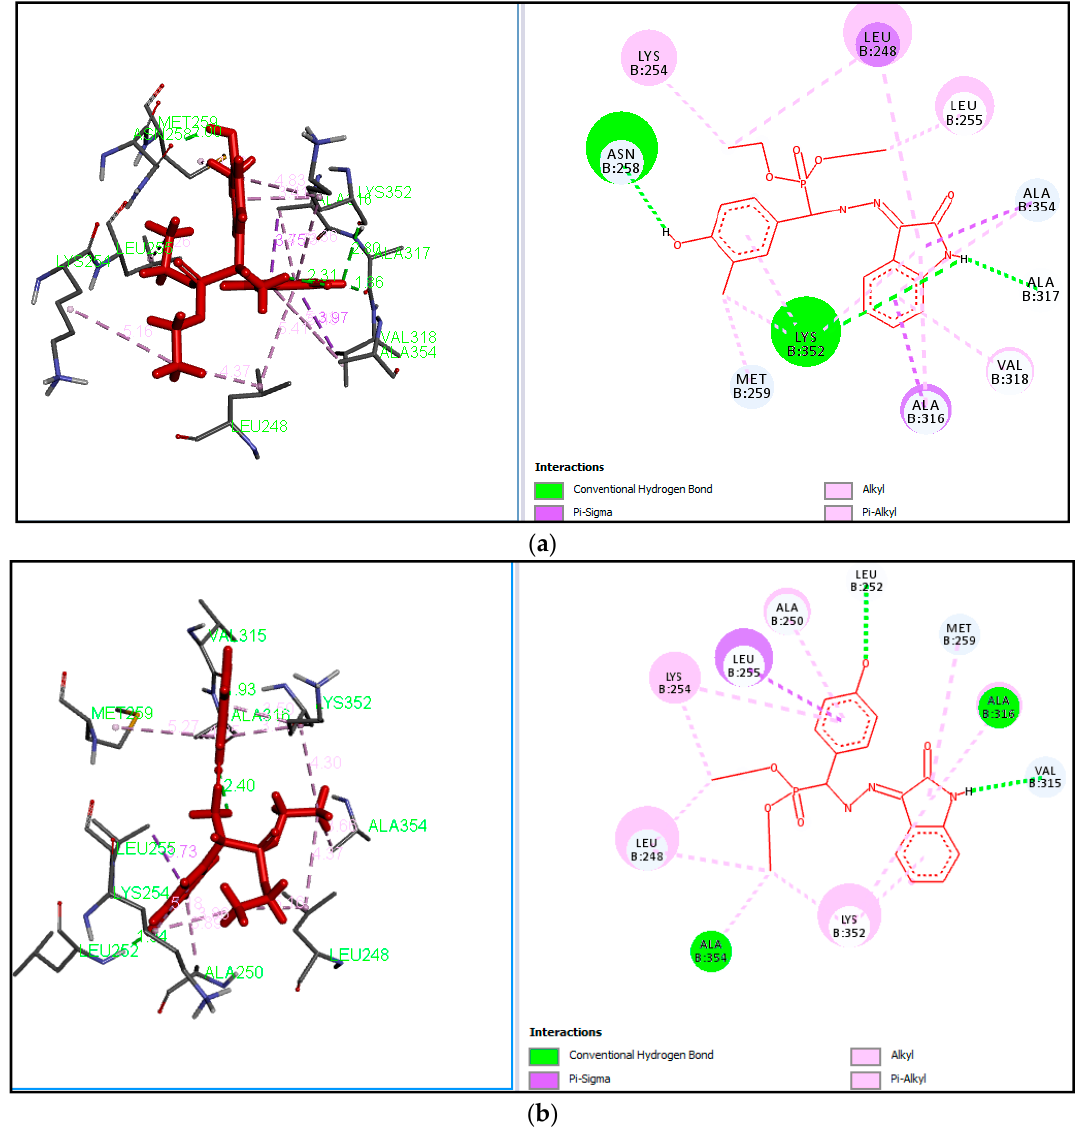
Figure 4. ( a ) Binding pose and molecular interactions of 4l into the active site of tubulin ( PDB ID: 1SA0 ); ( b ) Binding pose and molecular interactions of 4f into the active site of tubulin ( PDB ID: 1SA0 ).